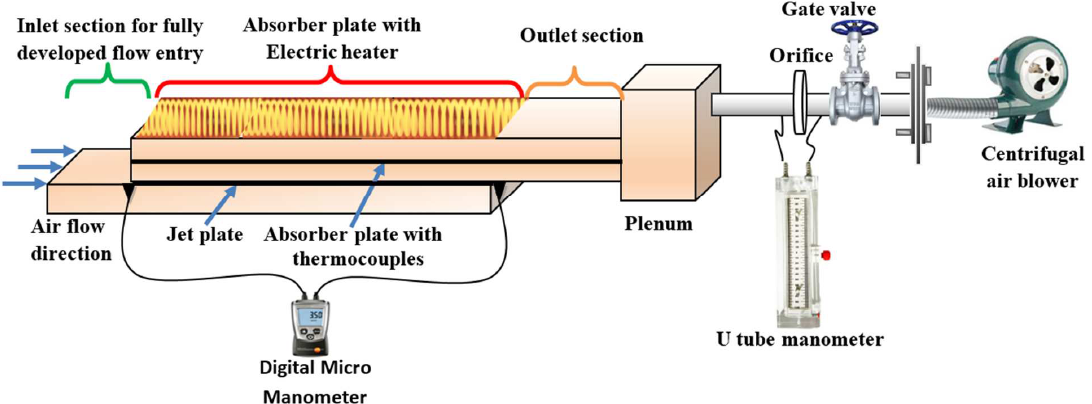
Figure 3. Schematic of experimental test facility.